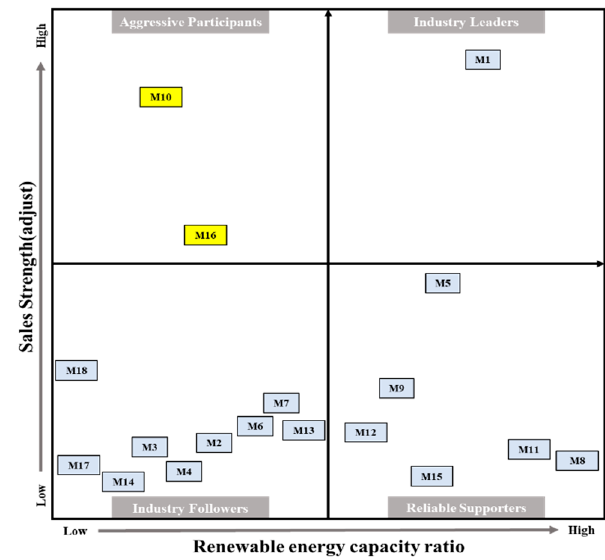
Figure 9. Power producer type matrix (adjusted).